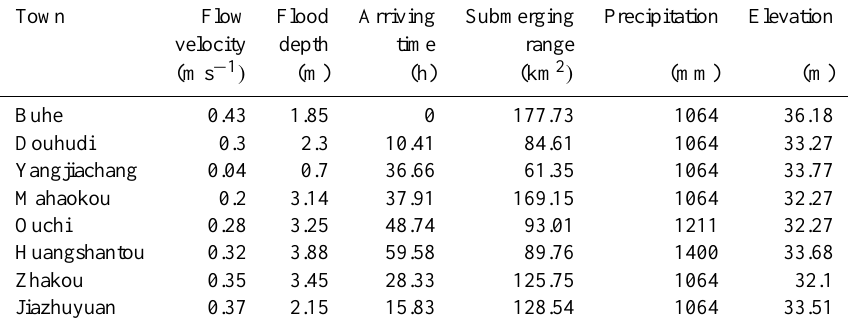
Table 1. Hazard characteristic by analyzing submerged condition.